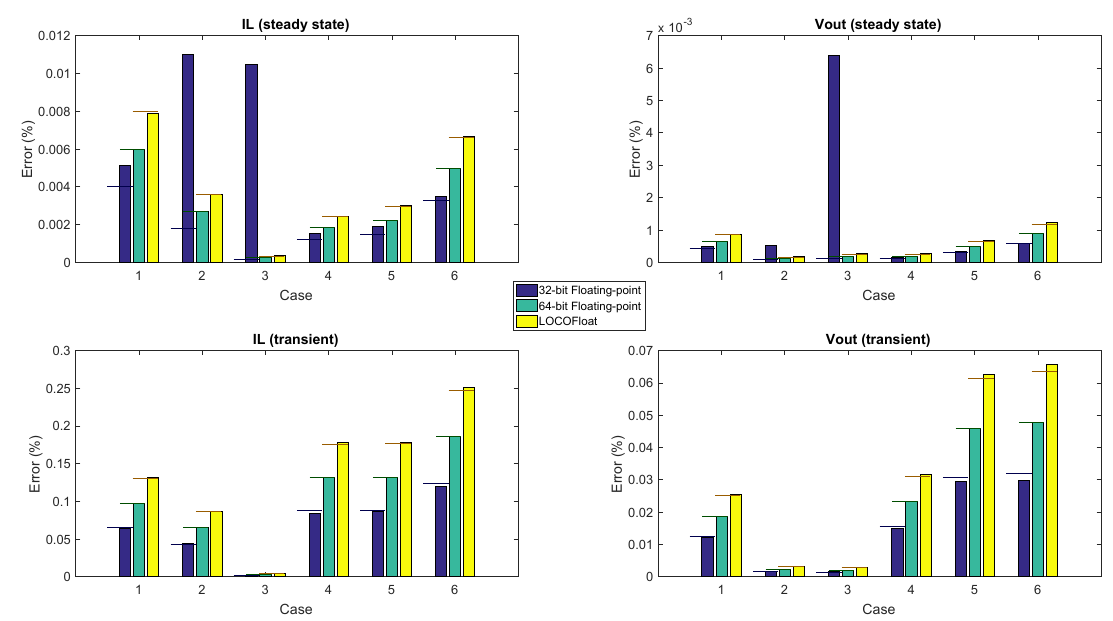
Figure 10. Accuracy results for all the arithmetics using their corresponding simulation step (20 ns, 30 ns and 40 ns, respectively). Percentage error related to the reference